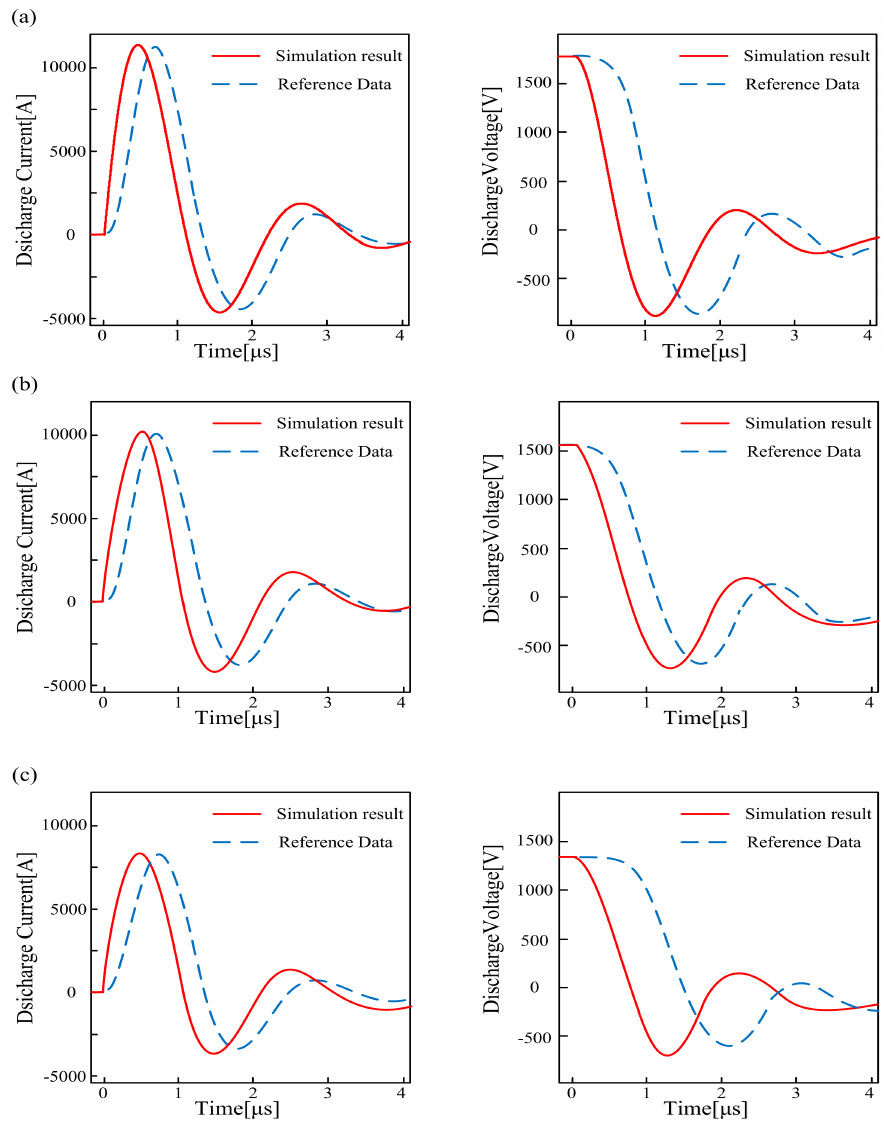
Figure 3. Comparisons of discharge current and voltage waveforms at different discharge energies between simulation results and reference data from Coletti [19]: ( a ) at 5 J discharge energy; ( b ) at 4 J discharge energy; and ( c ) at 3 J discharge